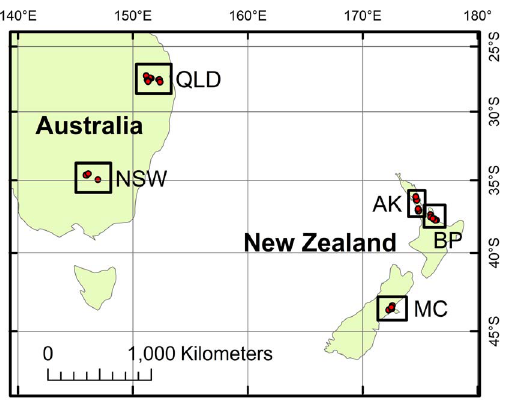
Figure 1. Australasian regions used to test biogeochemical markers for provenance assignment of H.armigera . These regions represent biogeochemical contrasts and similarities, and they are important areas with regard to biosecurity for both Australia and New Zealand. MC = Mid Canterbury, BP = Bay of Plenty, AK = Auckland, New Zealand; NSW = Wagga Wagga, QLD = Toowoomba, Australia.